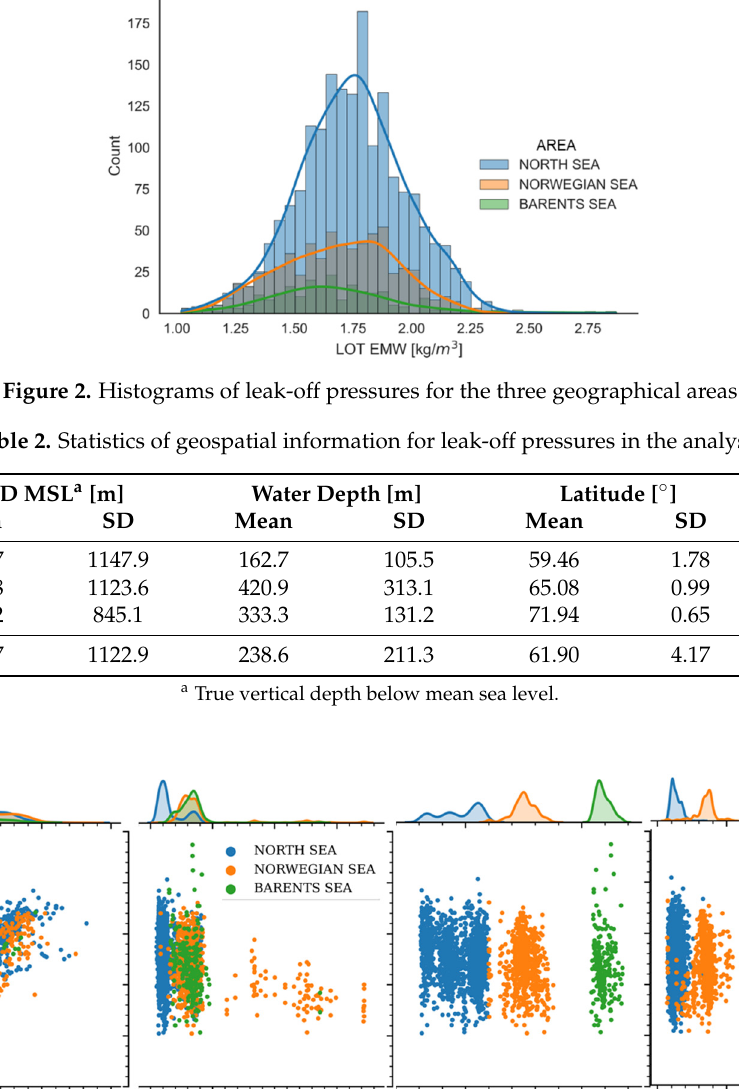
Figure 3. Joint scatter plots of leak-off pressure and geospatial information.